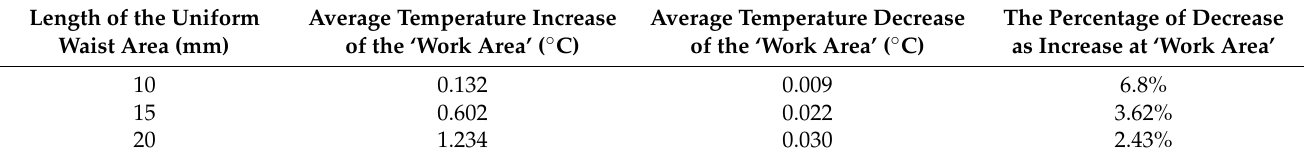
Table 1. The value of the relative change in ‘work area’ within 0.5 s.